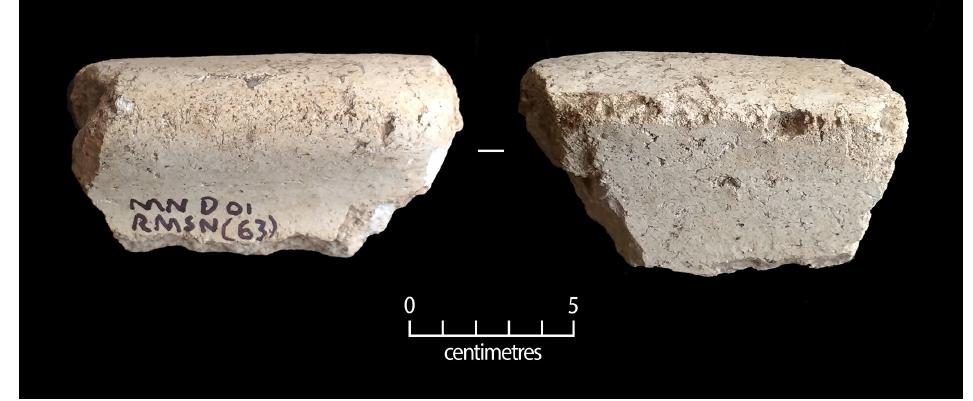
Figure 27: External and internal surfaces of a Class 8 variant 1